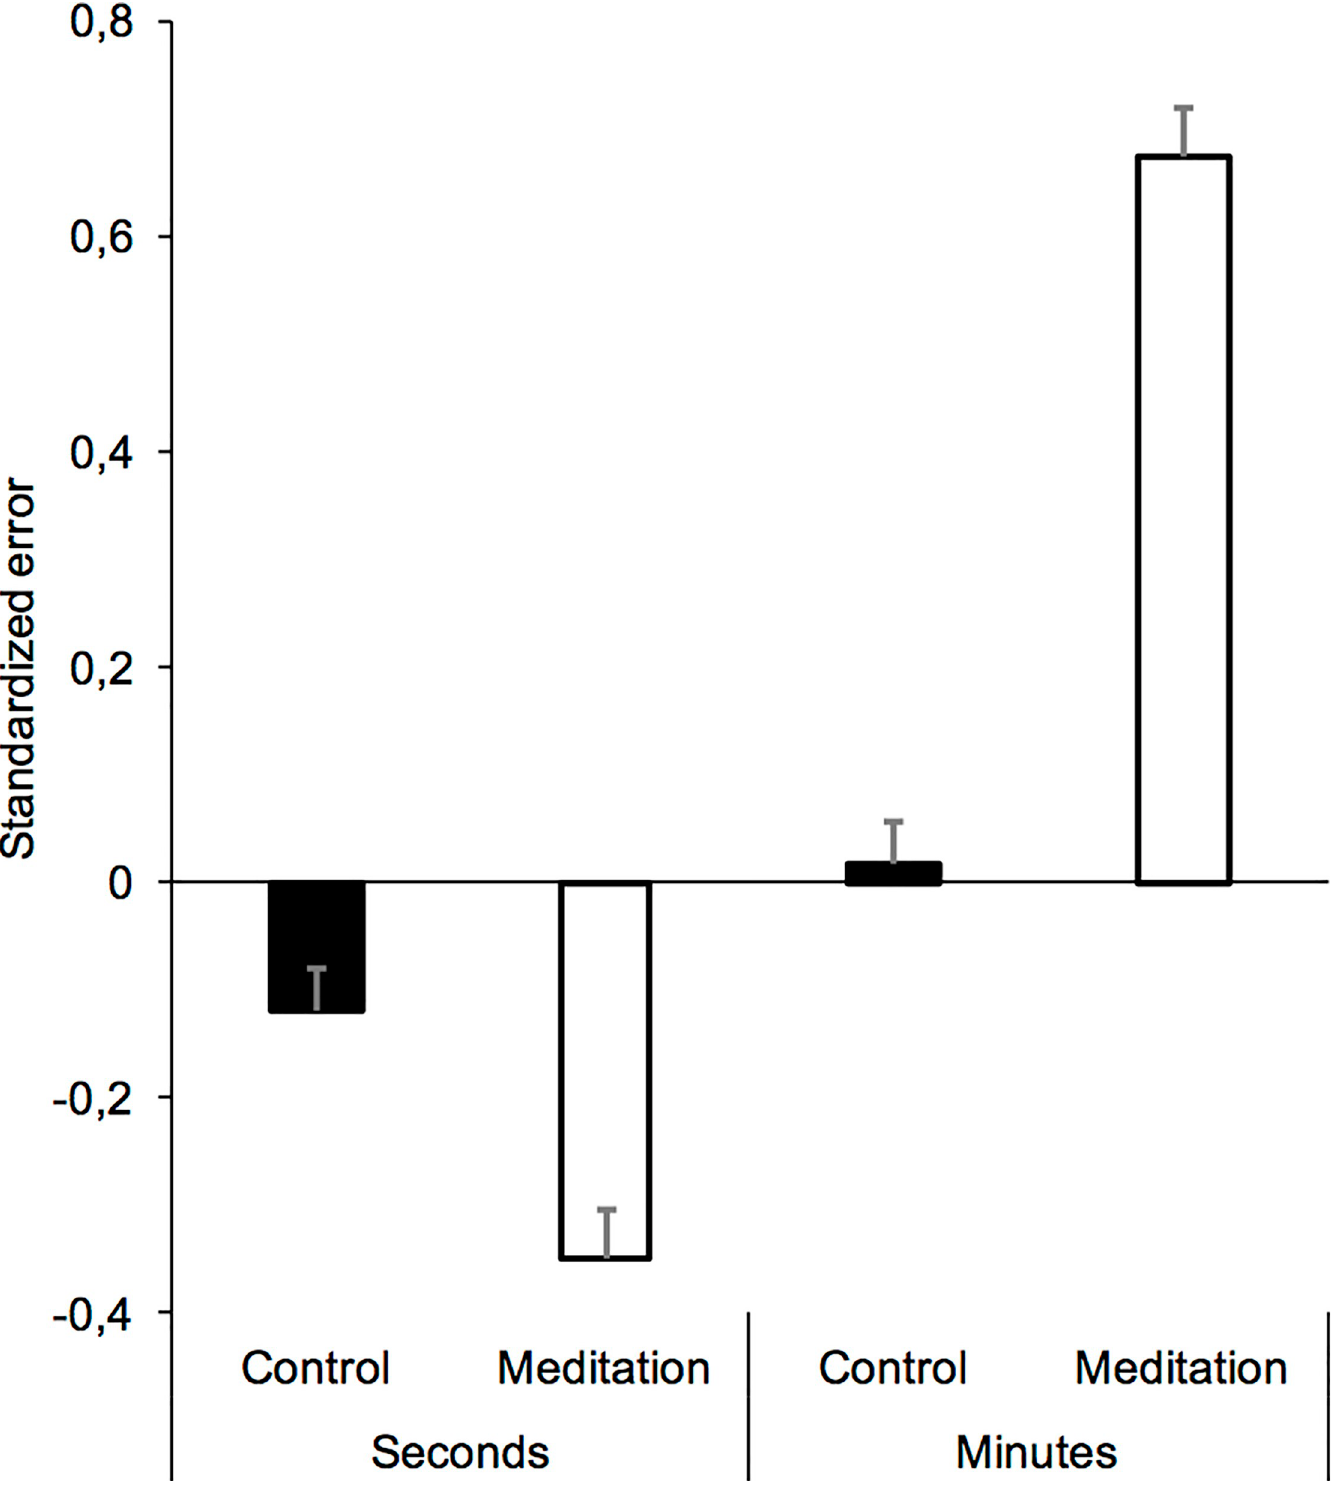
Fig 2. Time estimates. Mean temporal standardized error for the two ranges of interval durations (seconds and minutes) in the meditation and the control group ( bar errors = standard errors